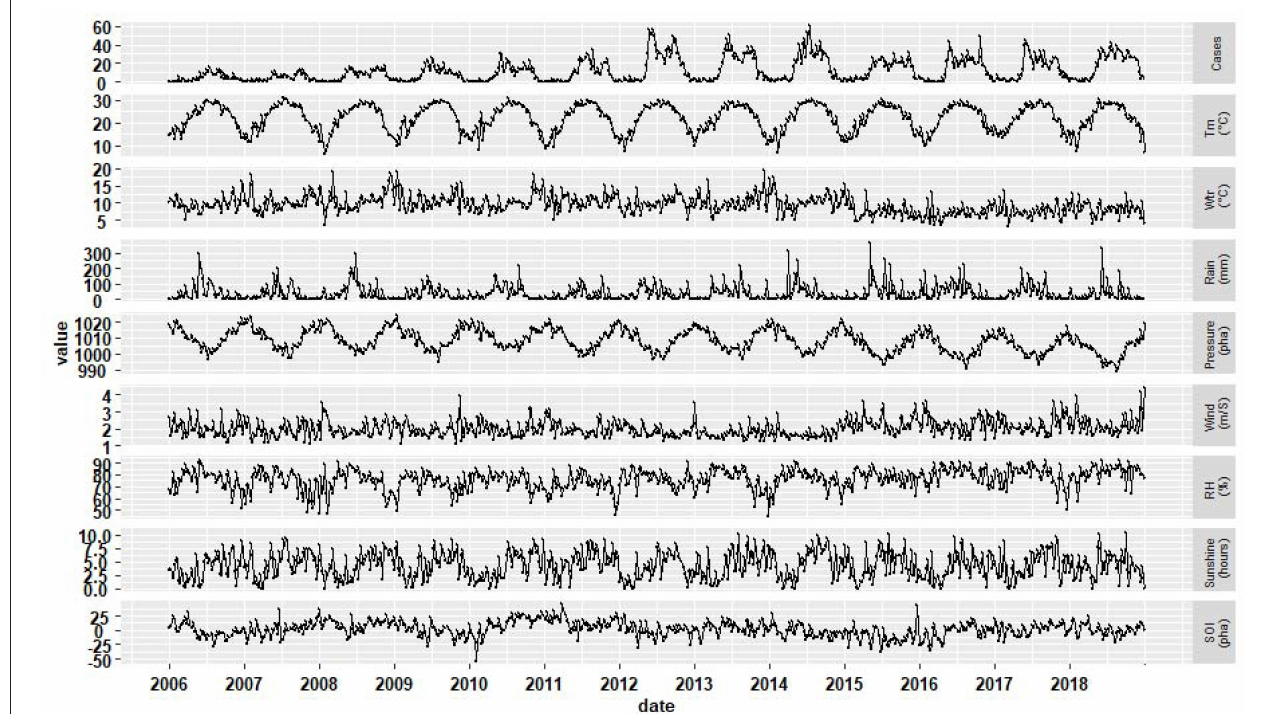
FIGURE 1 | The distribution of weekly scrub typhus cases, meteorological variables and SOI in Guangzhou, Southern China, 2006–2018.